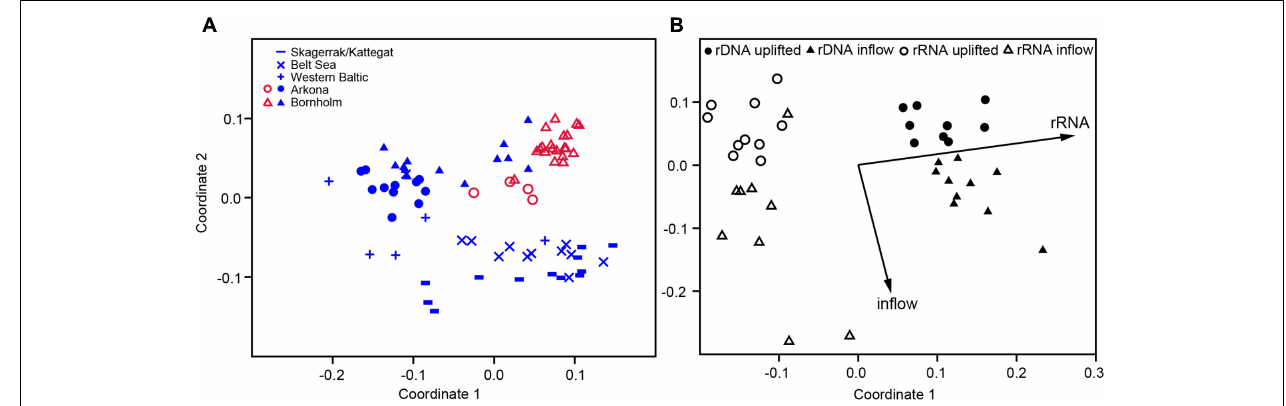
FIGURE 5 | (A) Non-metric multidimensional scaling (NMDS) plots (Bray–Curtis dissimilarity, NMDS stress = 0.1133) of bacterioplankton community composition from different basins of the Baltic Sea, based on the rDNA analysis. The blue symbols represent samples from a reference study (Herlemann et al., 2016), which included the Skagerrak/Kattegat, Belt Sea, Western Baltic, Arkona and Bornholm Basins, and the red symbols samples from this study, including the Arkona and Bornholm Basins. (B) NMDS plot (Bray–Curtis dissimilarity, NMDS stress = 0.1046) of bacterioplankton community composition from the Bornholm Basin (this study only) based on rRNA and rDNA analyses. Full symbols indicate DNA-based and open symbols RNA-based bacterial communities. Dots represent the uplifted water masses and triangles the inflow water. The environmental variables inflow vs. uplifted water masses and rDNA vs. rRNA were added as post hoc vectors to the NMDS graph, representing the correlations between the environmental variables and NMDS scores.